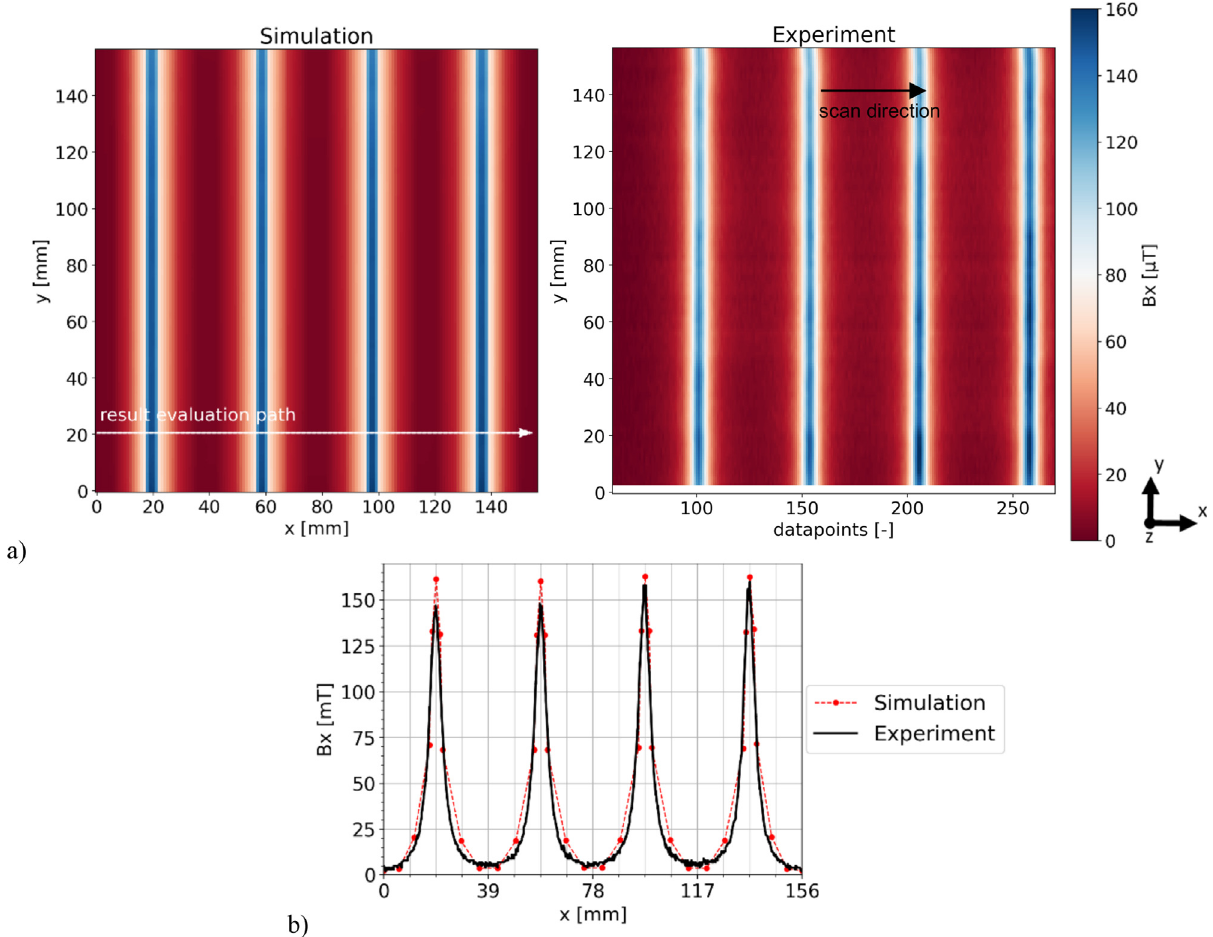
Fig. 4. X-component of the magnetic fi eld B x of a solar cell without busbar defects as heatmaps (a) and as a line plot perpendicular to the busbars (b) comparing the simulation and the